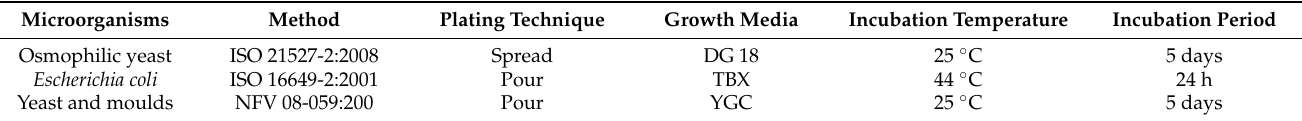
Table 1. Microbiological test methods information 1